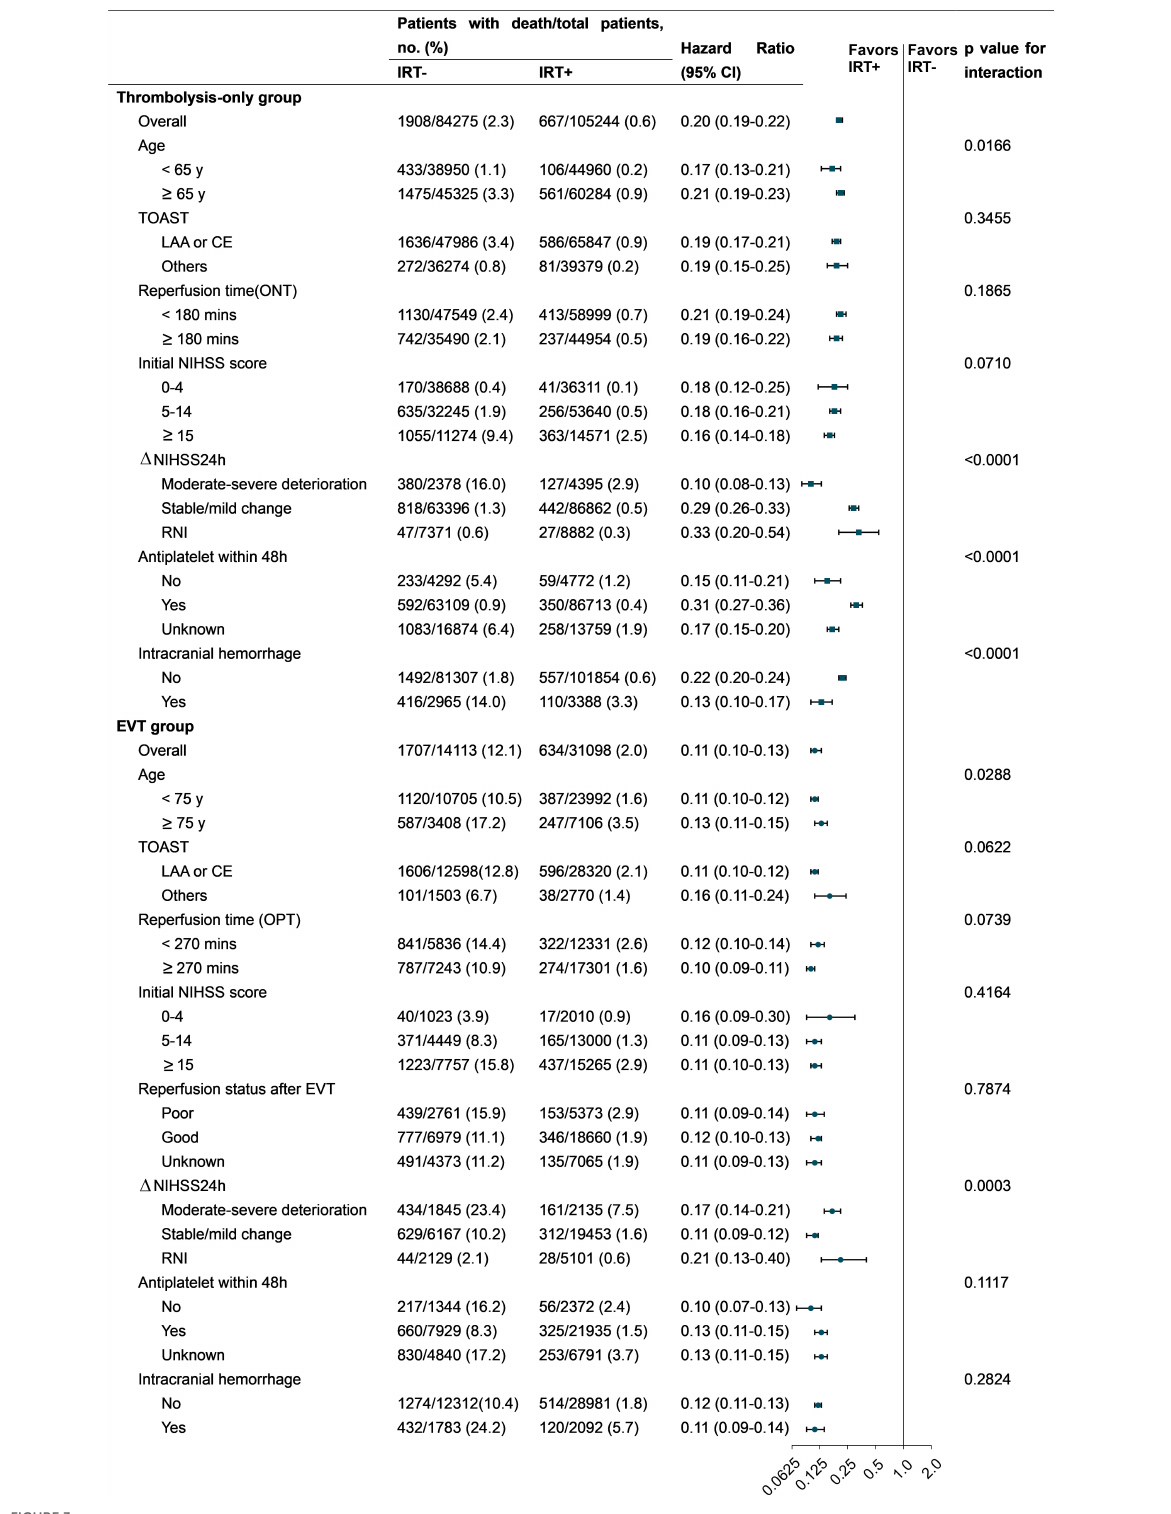
FIGURE3 HRs for all-cause in-hospital mortality in subgroup analyses. CE, cardioembolism; EVT, endovascular therapy; IRT, inpatient rehabilitation therapy; LAA, large artery atherosclerosis; NIHSS, National Institutes of Health Stroke Scale; RNI, rapid neurological improvement; ONT, onset-to-needle time; OPT, onset-to-puncture time. Others of TOAST: small artery occlusion/ stroke of other determined cause/stroke of undetermined cause. Forest plots: (1) square for the thrombolysis-only group and (2) round for the EVT